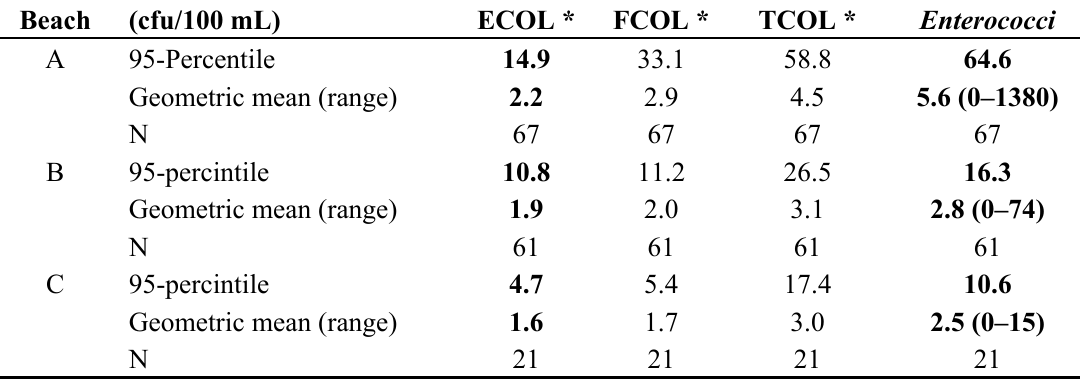
Table 2. Sea water microbiological analysis results for the three beaches.